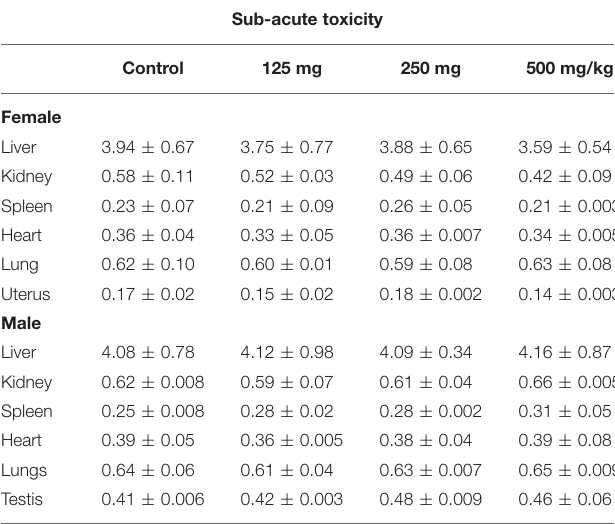
TABLE 4 | Effect of fungal taxol on the relative organ weight of control and treated Wistar rats in the sub-acute toxicity